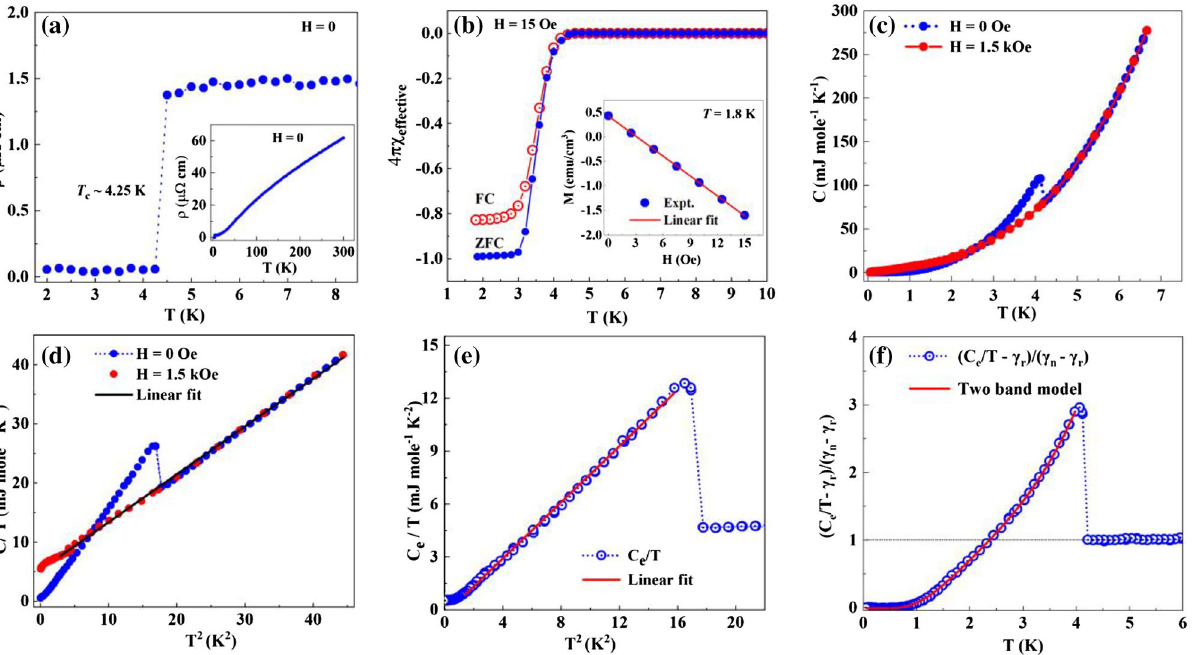
Figure 1. Superconductivity in PdTe. ( a ) Zero-field electrical resistivity of PdTe at low temperatures showing zero resistance below 4.25 K. Inset: Temperature dependence of the electrical resistivity between 2 and 300 K. ( b ) Magnetic susceptibility of PdTe in both ZFC and FC modes. Inset: magnetization as a function of H at 1.8 K, where the solid line is a fit of M using M = A ( H - H 0 ) for determining the residual field H 0 . ( c ) Specific heat ( C ) of PdTe under H = 0 and 1.5 kOe. ( d ) C / T versus T 2 . The black solid line is the fit of the data under field to the relation C / T = γ + β T 2 . ( e ) Electronic specific heat plotted as C e / T versus T 2 . The solid line represents the line fit of data. ( f ) ( C e / T − γ r )/(γ n − γ r ) versus T . The solid line is the fit of data to the two-band model (see